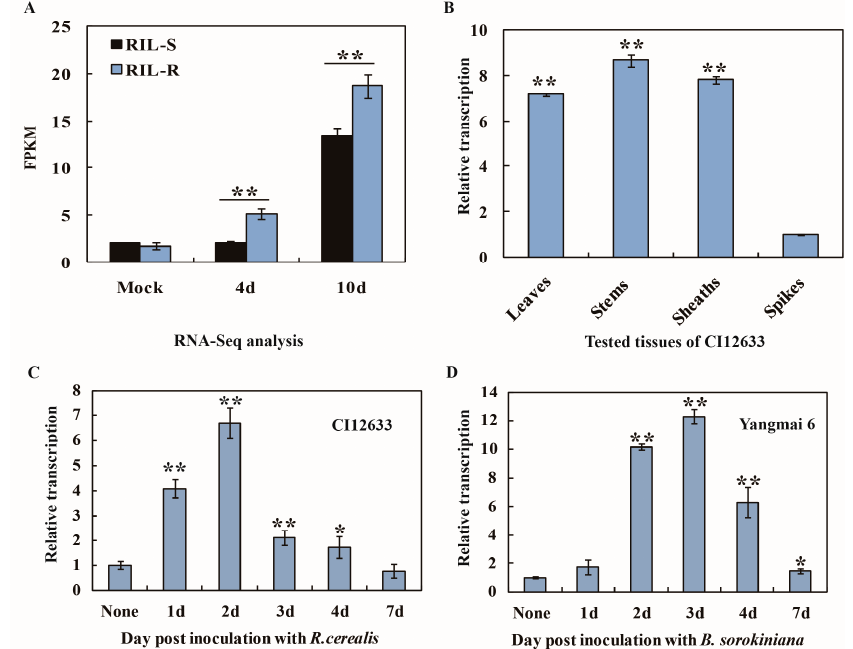
Figure 1. RNA-Seq and qRT-PCR analyses on transcriptional profiles of TaCRR1 in the wheat responses to Rhizoctonia cerealis and Bipolaris sorokiniana . ( A ) RNA-Seq data of TaCRR1 transcription in the resistant RILs (RIL-R) and in susceptible RILs (RIL-S) (use the same in text as in Figure 1A). ( B ) Transcription of TaCRR1 in stems, leaves, sheaths, and spikes of CI12633 plants. The transcriptional level of TaCRR1 in spikes was set to 1. ( C ) qRT-PCR analysis of TaCRR1 in the resistant wheat Yangmai 6 plants inoculated with B. sorokiniana . ( D ) qRT-PCR analysis of TaCRR1 in the resistant wheat cv. CI12633 plants inoculated with R. cerealis . The transcriptional level of TaCRR1 at none (non-treatment) is set to 1. Statistically significant differences were derived from the results of three independent replications ( t -test: *0.01 < p < 0.05, ** p < 0.01). TaGAPDH was used as an internal control.